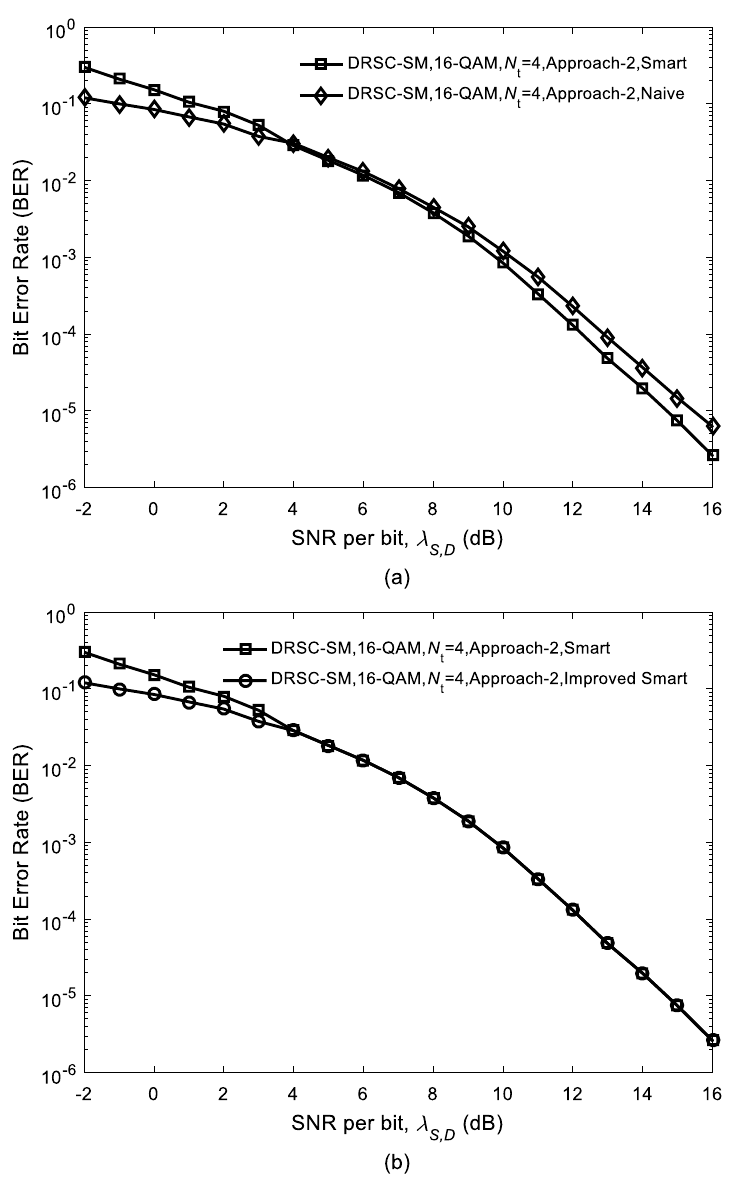
performance of DRSC-SM scheme employing smart